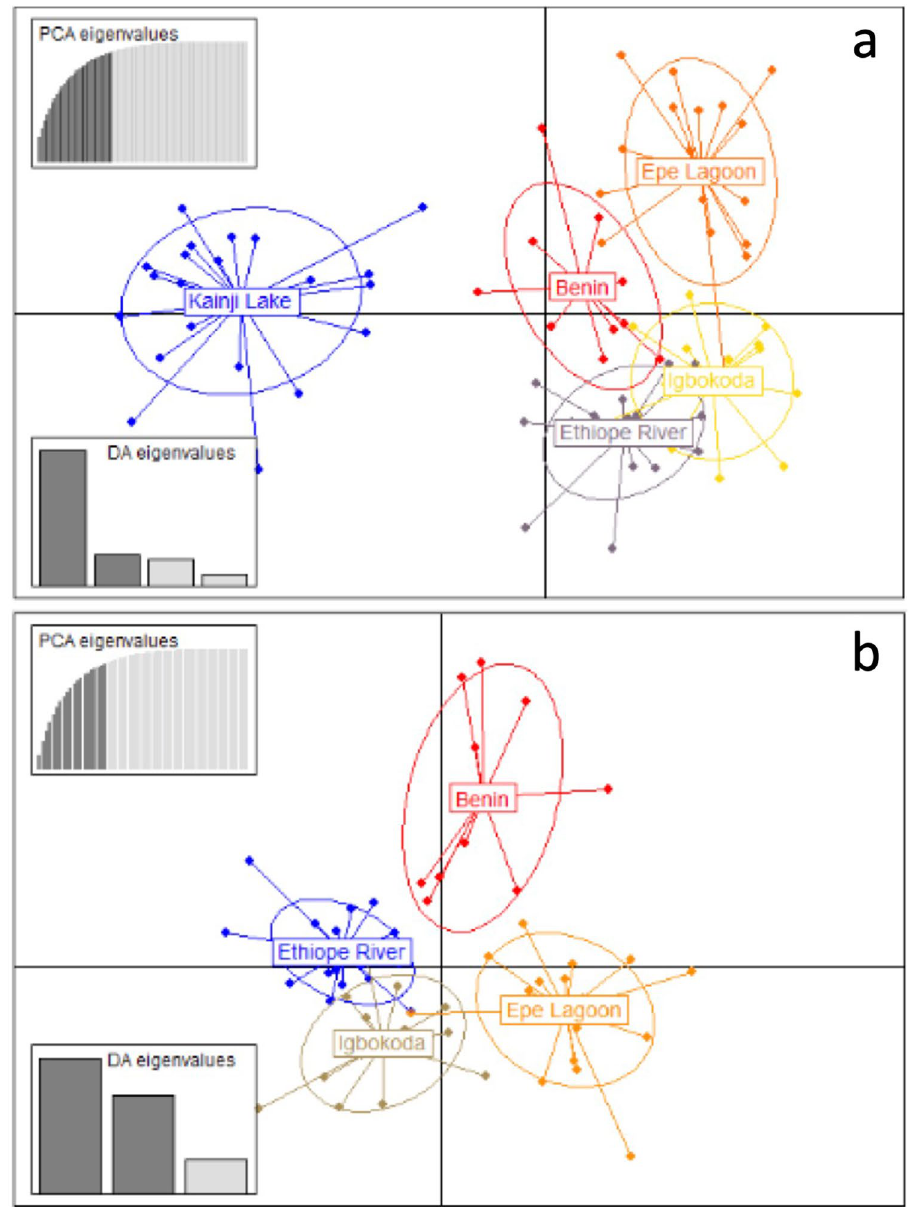
Figure 2. Cross-validated DAPC scatter plots (dots represent individuals) using sampling locations as a priori groups: ( a ) including all individuals from the five sampling locations (30 PCs); ( b ) including only the individuals from the southern populations (20